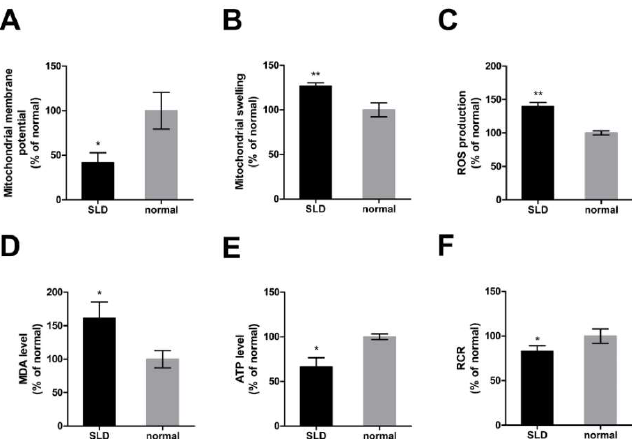
Figure 3. Impaired mitochondrial function in SLD chicken skeletal muscle. ( A ) Mitochondrial ∆Ψ m was measured by the fluorescence of JC-1 in SLD and normal chicken skeletal muscle. Red fluorescence represents aggregation of JC-1, green fluorescence represents monomeric JC-1, and ∆Ψ m was represented as the ratio of aggregated and monomeric JC-1. ( B ) Mitochondrial swelling was measured by the absorbance at 540 nm of mitochondria isolated from SLD and normal chicken skeletal